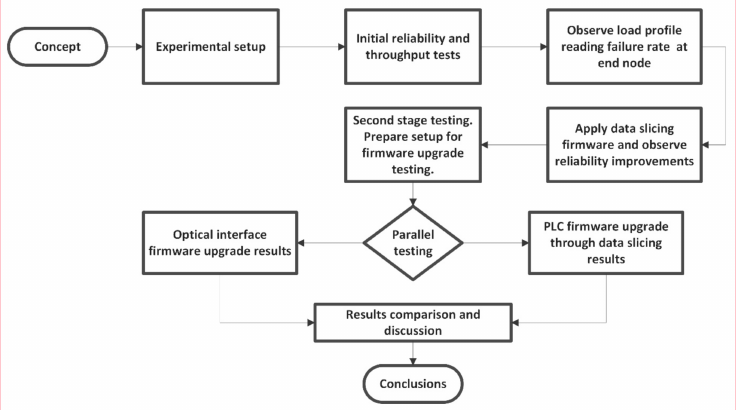
Figure 3. Flow chart diagram of the proposed method and its testing methods.